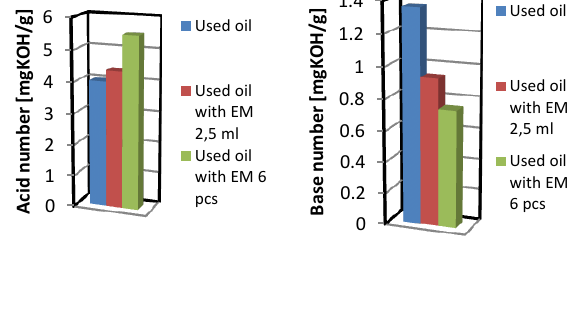
Fig. 12. Acid and base number of used oil and used oil with EM in liquid form and ceramic